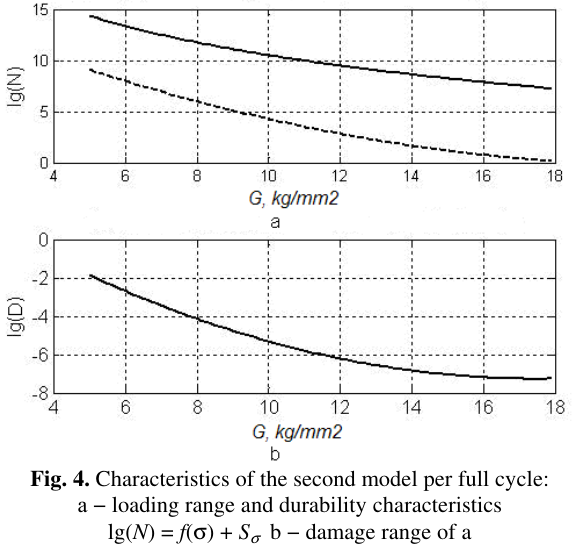
Fig. 4. Characteristics of the second model per full cycle: а − loading range and durability